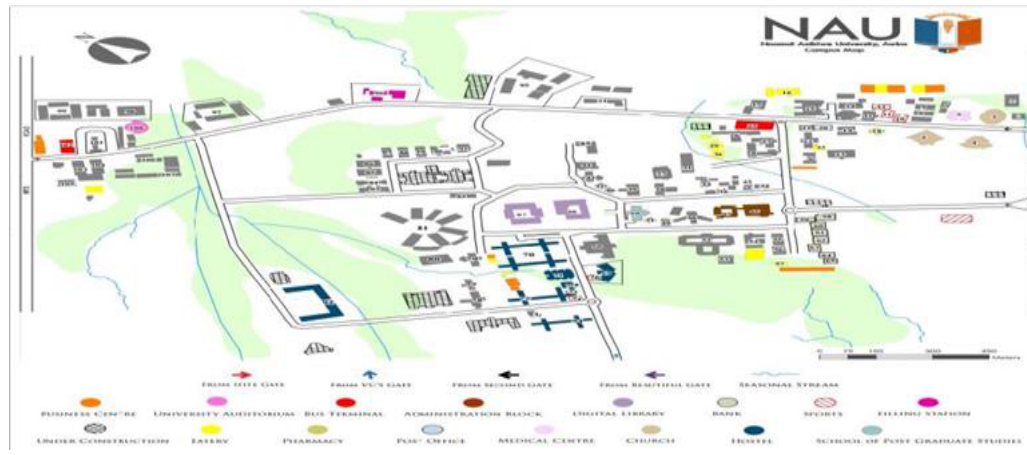
Figure 1. Map of Nnamdi Azikiwe University (NAU) Awka, Anambra